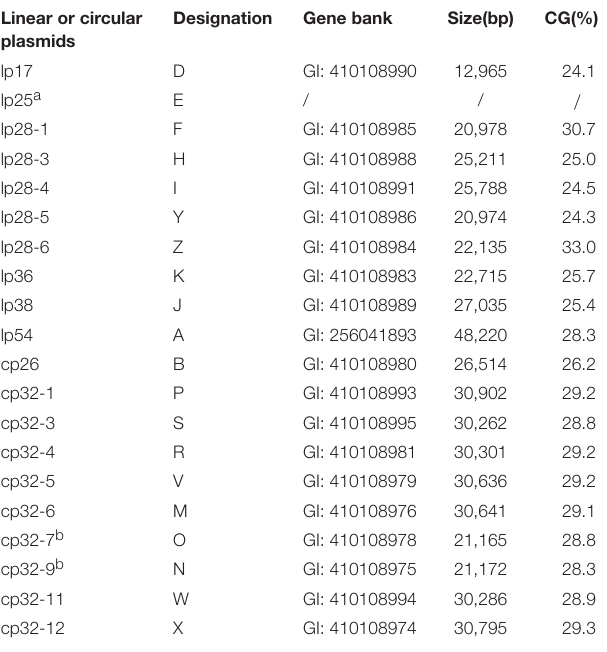
TABLE 1 | List of endogenous plasmids in B. burgdorferi strain